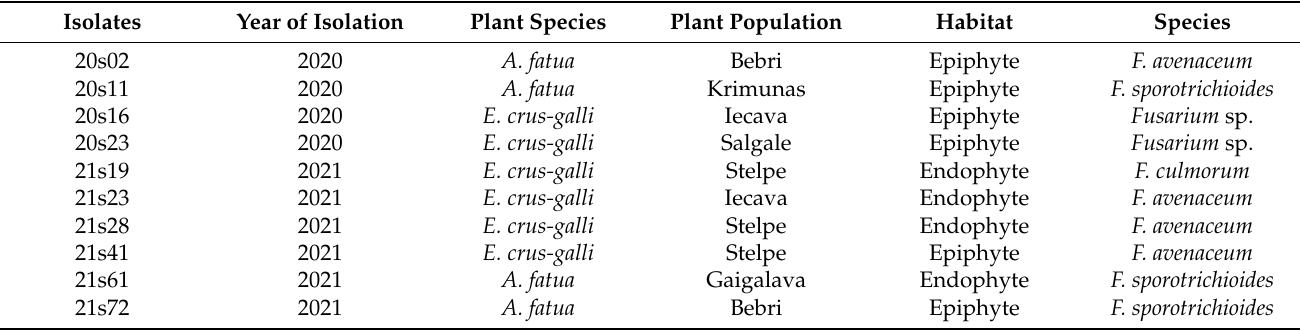
Table 3. Fusarium isolates used for inoculating seeds of E. crus-galli in laboratory